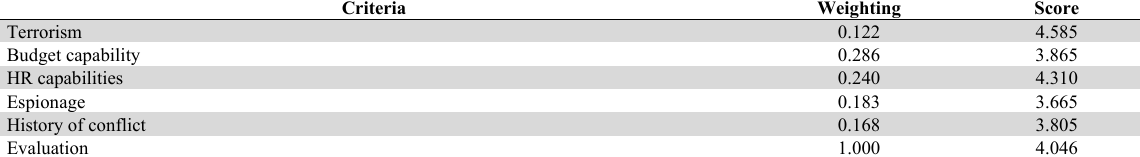
The weighting of Social Vulnerability Variables of State Borders